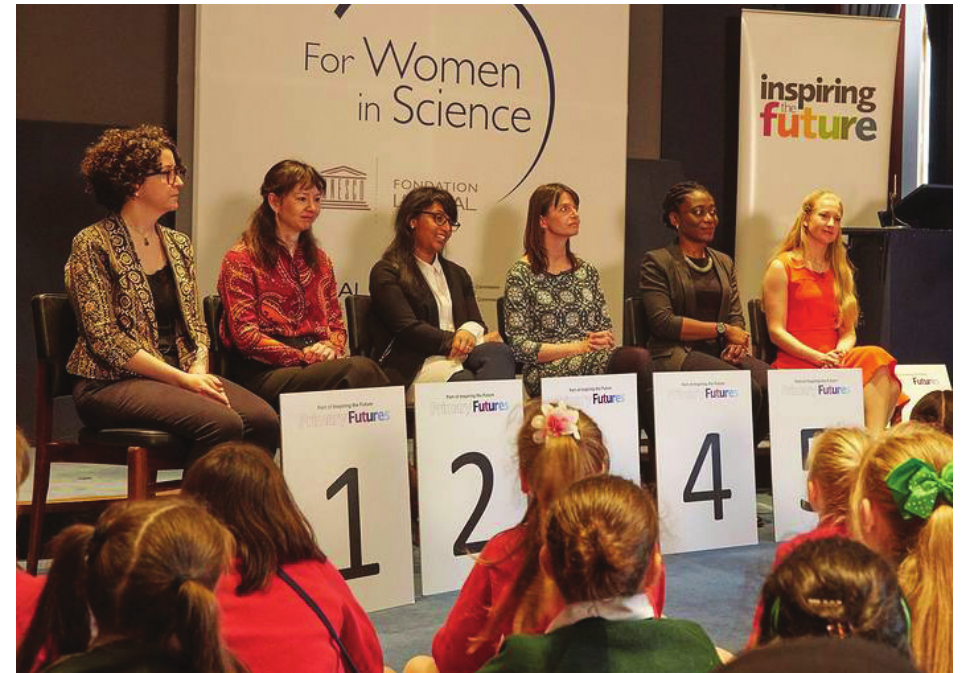
Figure 5: Carolyn Rando (on left) at the Inspiring Women in Science event (Photo The Educa- tion and Employers